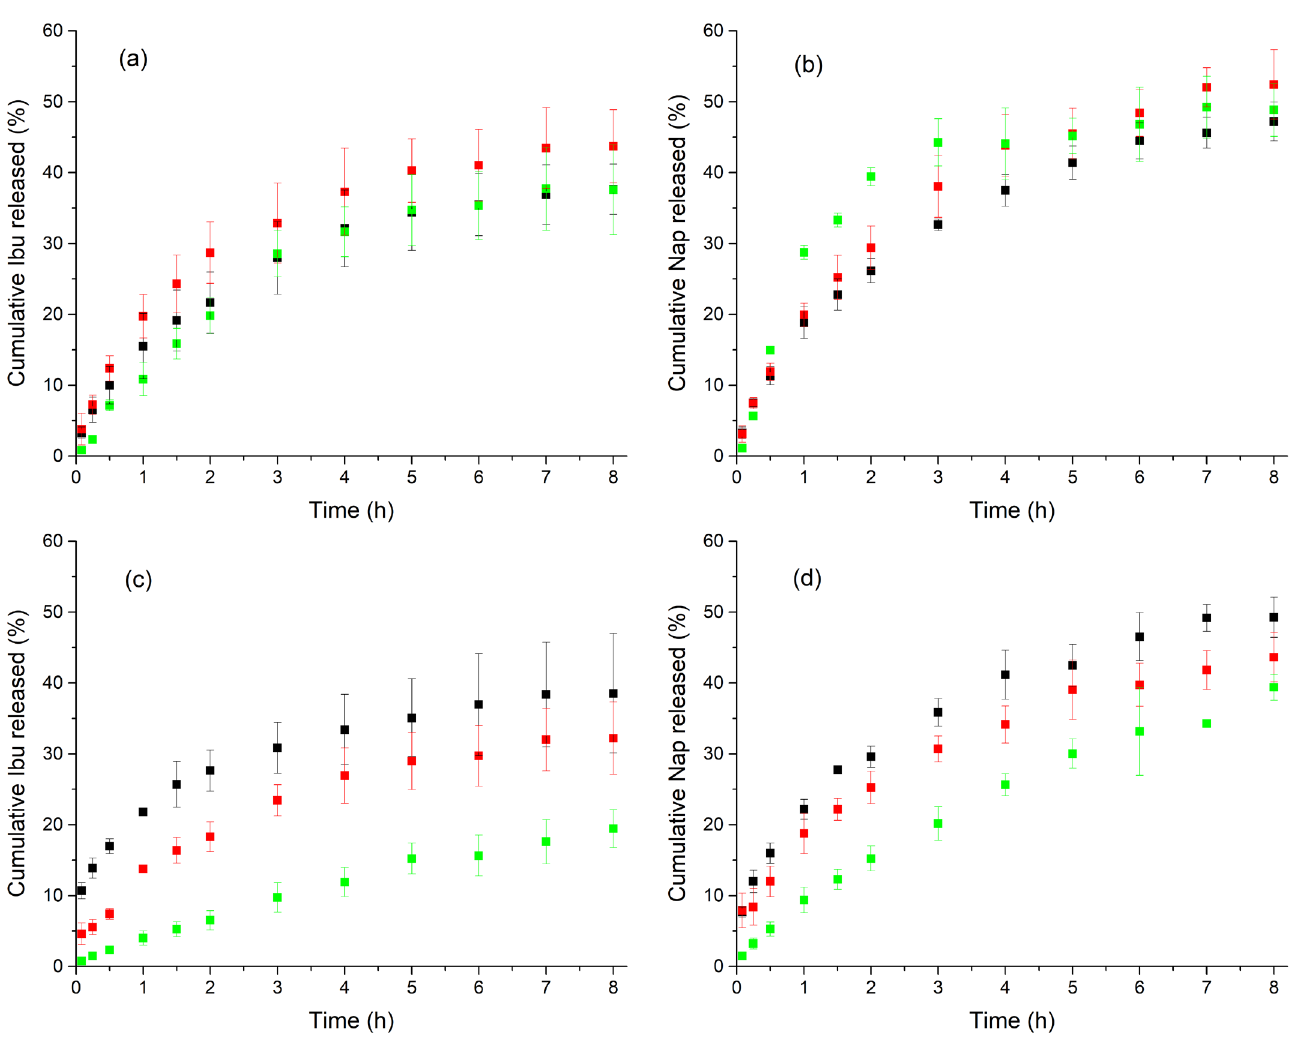
Figure 4. In vitro release profiles ), using bicompartmental cells filled with PBS ( a , b ) and SBF ( c , d ), of Ibu ( a , c ) and Nap ( b , d ) from LDH-Drug/Alg dispersions at two different concentrations: 5 g L − 1 (green), and 0.5 g L –1 (red), and Alg dispersions with the pure drug at a concentration equivalent to that of 0.5 g L –1 LDH-Drug/Alg